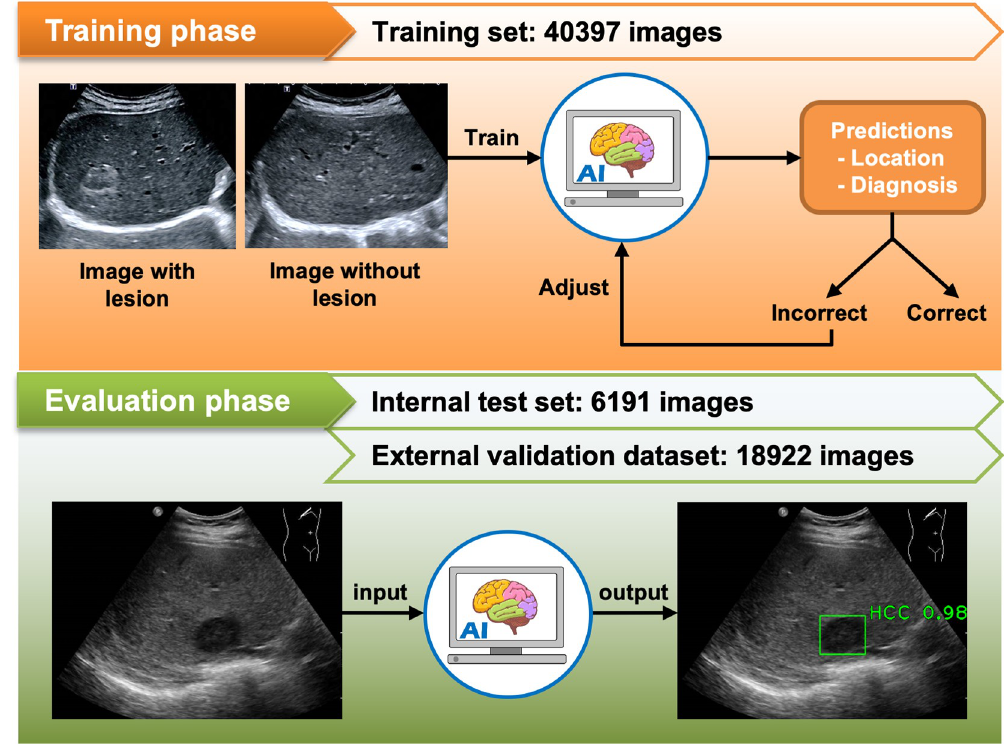
Fig 2. Process of AI system training and